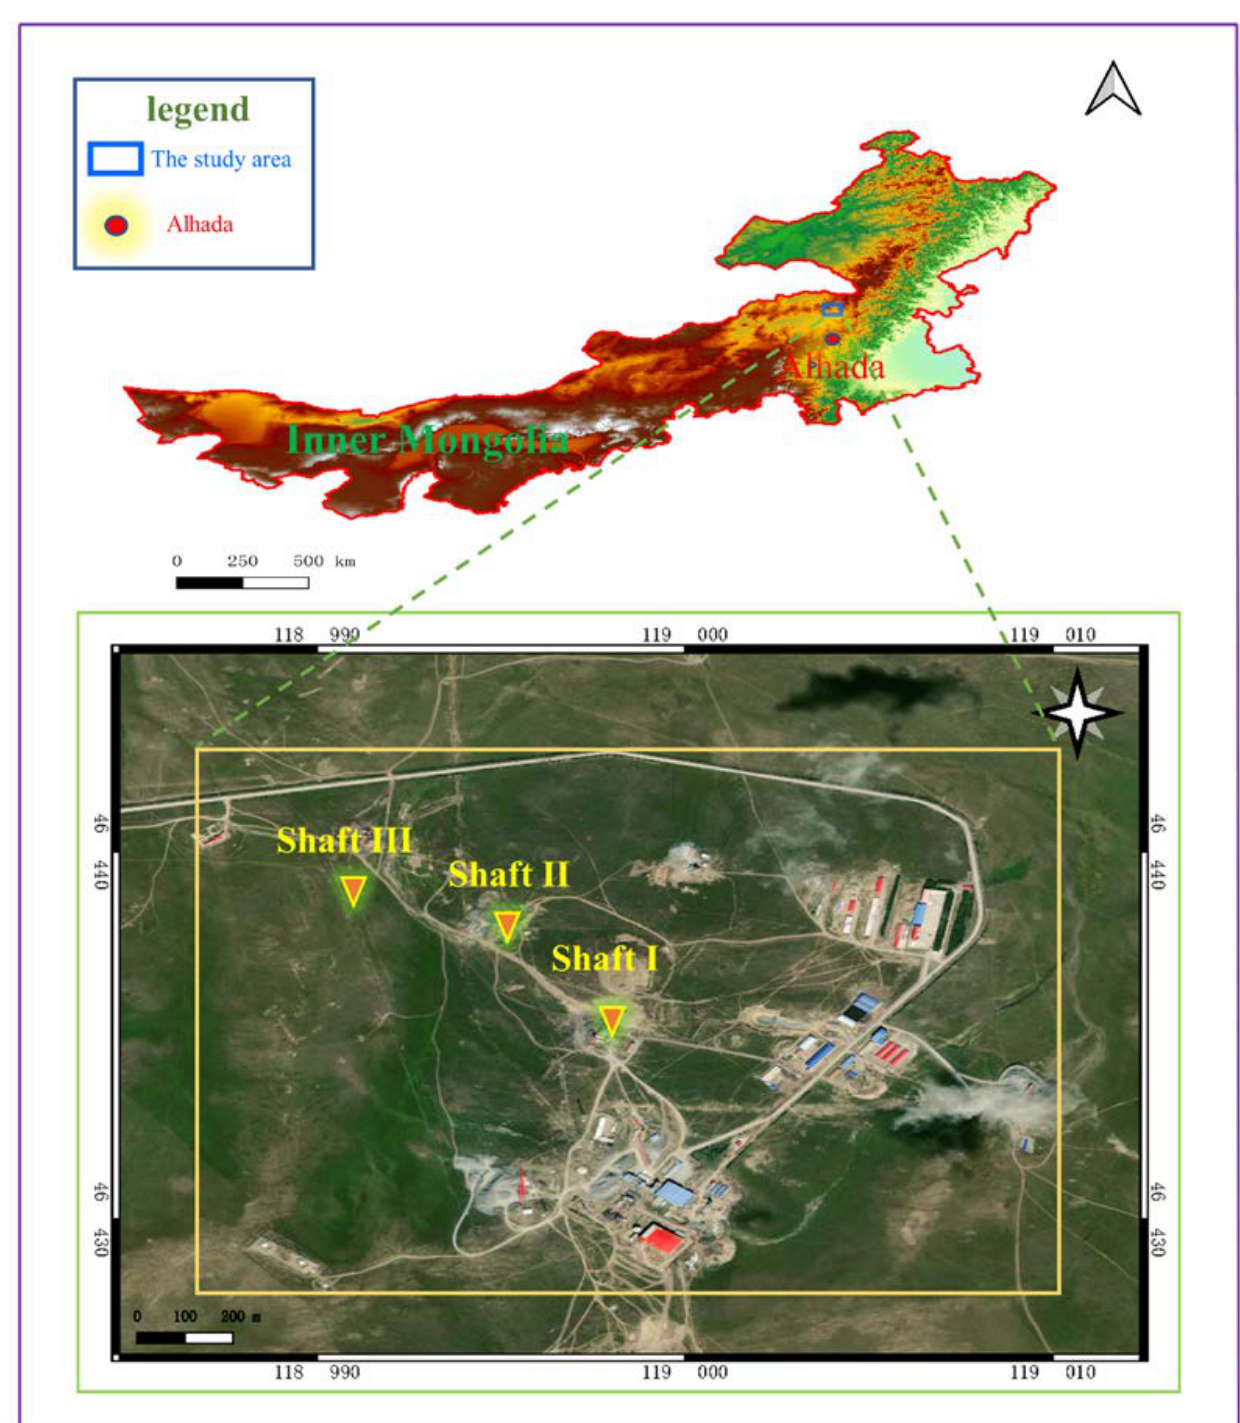
Figure 1. Location of the mining area. The upper portion represents the border of Inner Mongolia, China, and the background is the shaded DEM. The blue box indicates the study area. The lower portion is a satellite image of the mine area. The red triangles indicate the locations of shaft I, shaft II, and shaft III. (Satellite image is taken from Google Maps.)